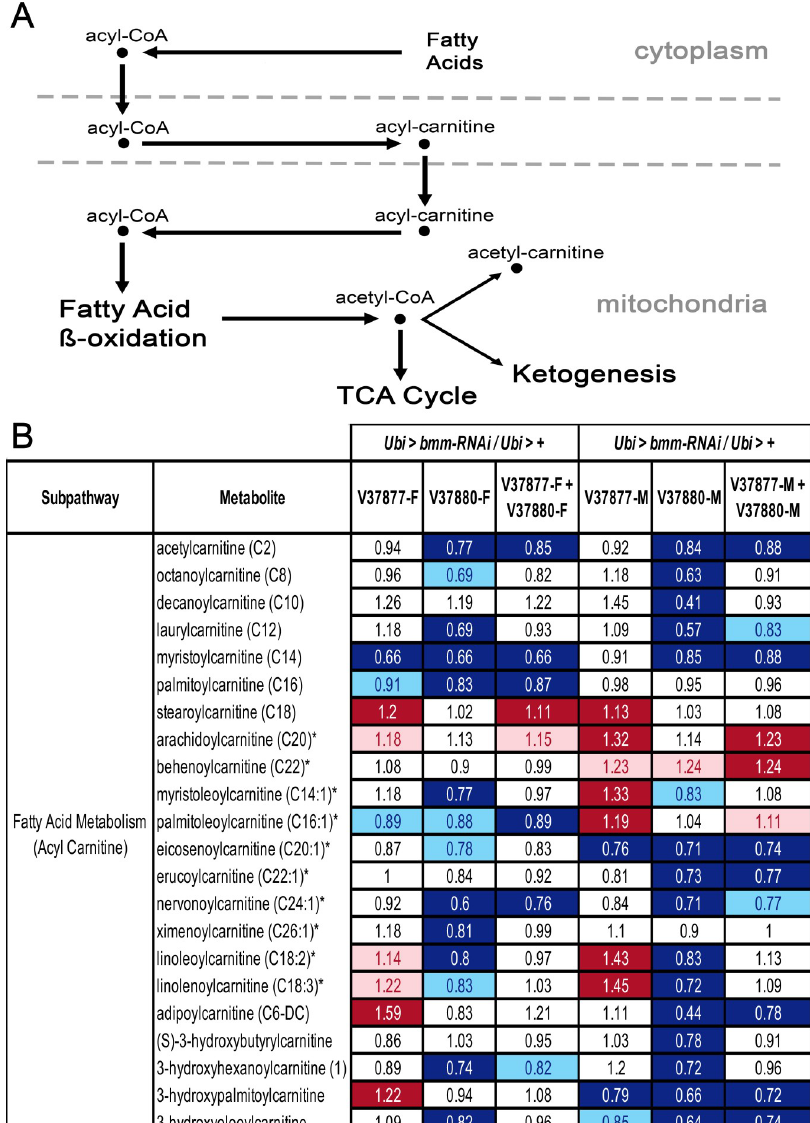
Fig 6. Compounds of acyl carnitine/fatty acid metabolism with altered abundance levels in Ubi > bmm-RNAi flies. (b) Diagram of the acyl carnitine/fatty acid metabolic pathway, highlighting the role of carnitine in facilitating transport of fatty acids into the mitochondria for fatty acid oxidation. (b) Heat map of changes in biochemicals of acyl carnitine/fatty acid metabolism in flies in which bmm is downregulated ( Ubi > bmm-RNAi ) compared with control flies ( Ubi > +). Red and dark blue represent the metabolites that increased and decreased respectively at p � 0.05, light red and light blue represent the metabolites that increased and decreased respectively at 0.05 � p � 0.1 (q-value is reported in S1 Dataset). Asterisks indicate compounds that have not been confirmed based on a standard.